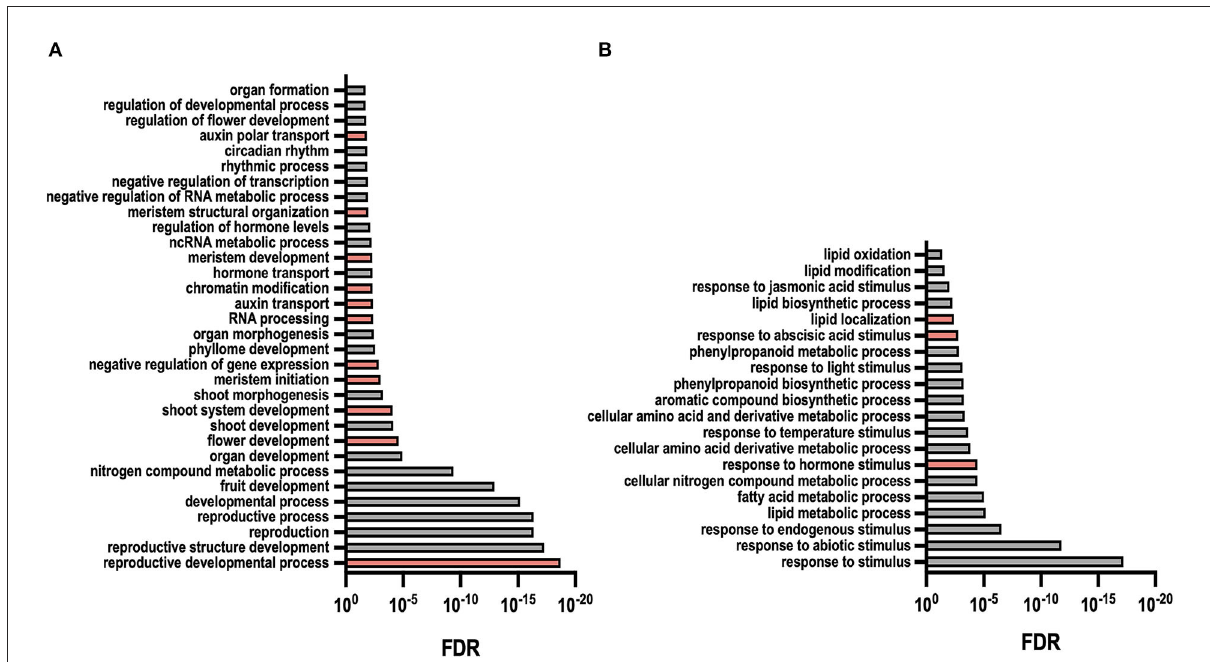
FIGURE4 Gene ontology term (biological processes) enrichment among differentially expressed genes in WT/ veg1 transcriptome. (A) Selected GO terms returned from the analysis of genes upregulated in veg1 . (B) Selected GO terms returned from the analysis of genes downregulated in veg1 . Terms were selected according to their relation to previously described VEG1 function and/or potential VEG1 mechanisms of action. All depicted terms were overrepresented (false discovery rate (FDR) < 0.05). A complete list of all enriched GO terms for each analysis is detailed in Supplementary Table